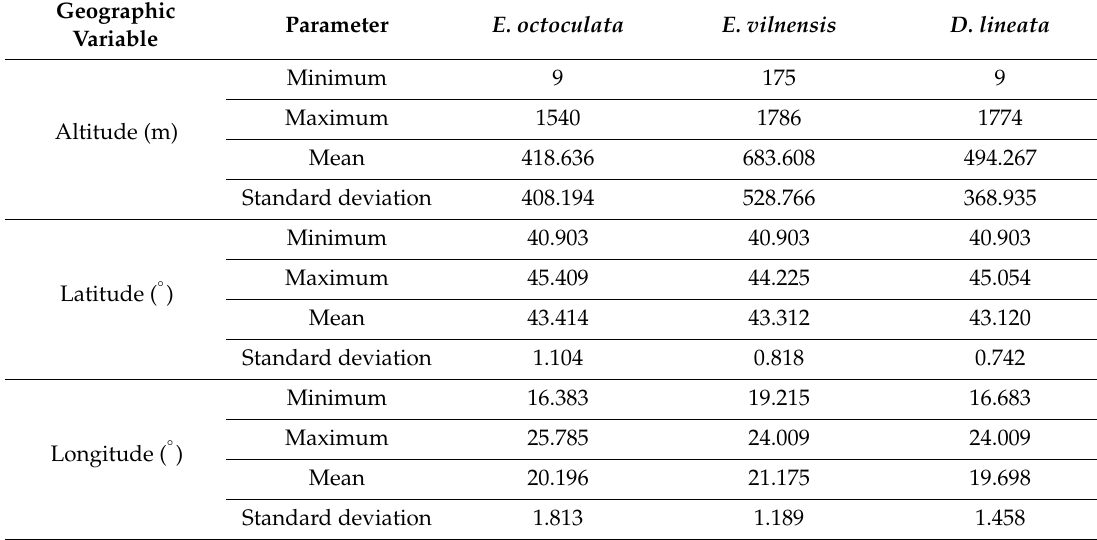
Table 4. The geographic variation of the sites inhabited by the analyzed species.